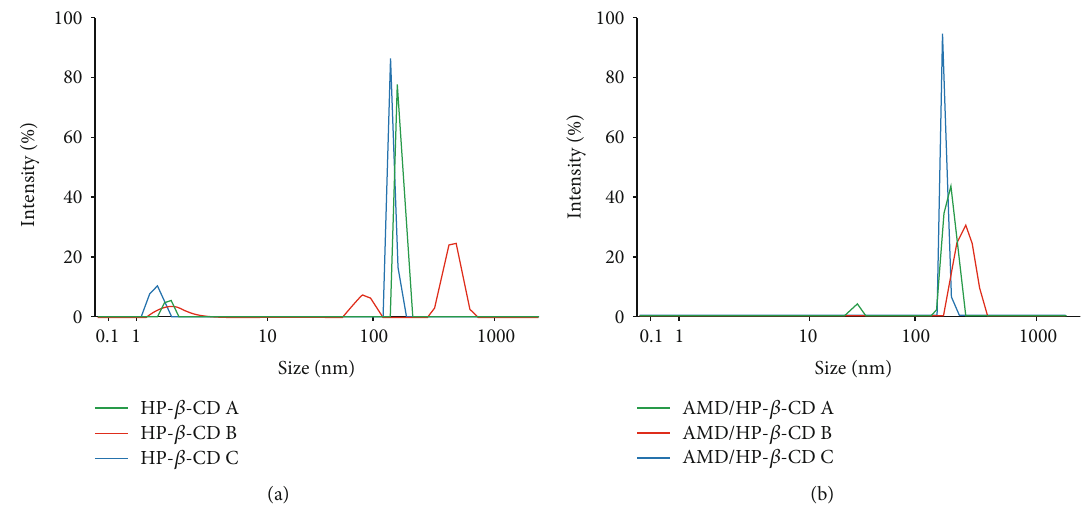
Figure 4: Size distribution curves of cyclodextrins and corresponding inclusion complexes: (a) of HP- β -CD A, HP- β -CD B, and HP- β -CD C and (b) of AMD/HP- β -CD A, AMD/HP- β -CD B, and AMD/HP- β -CD C in aqueous solution ( c = 0 : 07 gdL ‐ 1 ) as determined by DLS. Table 3: Z -average, PDI (polydispersity index), and zeta potential results.